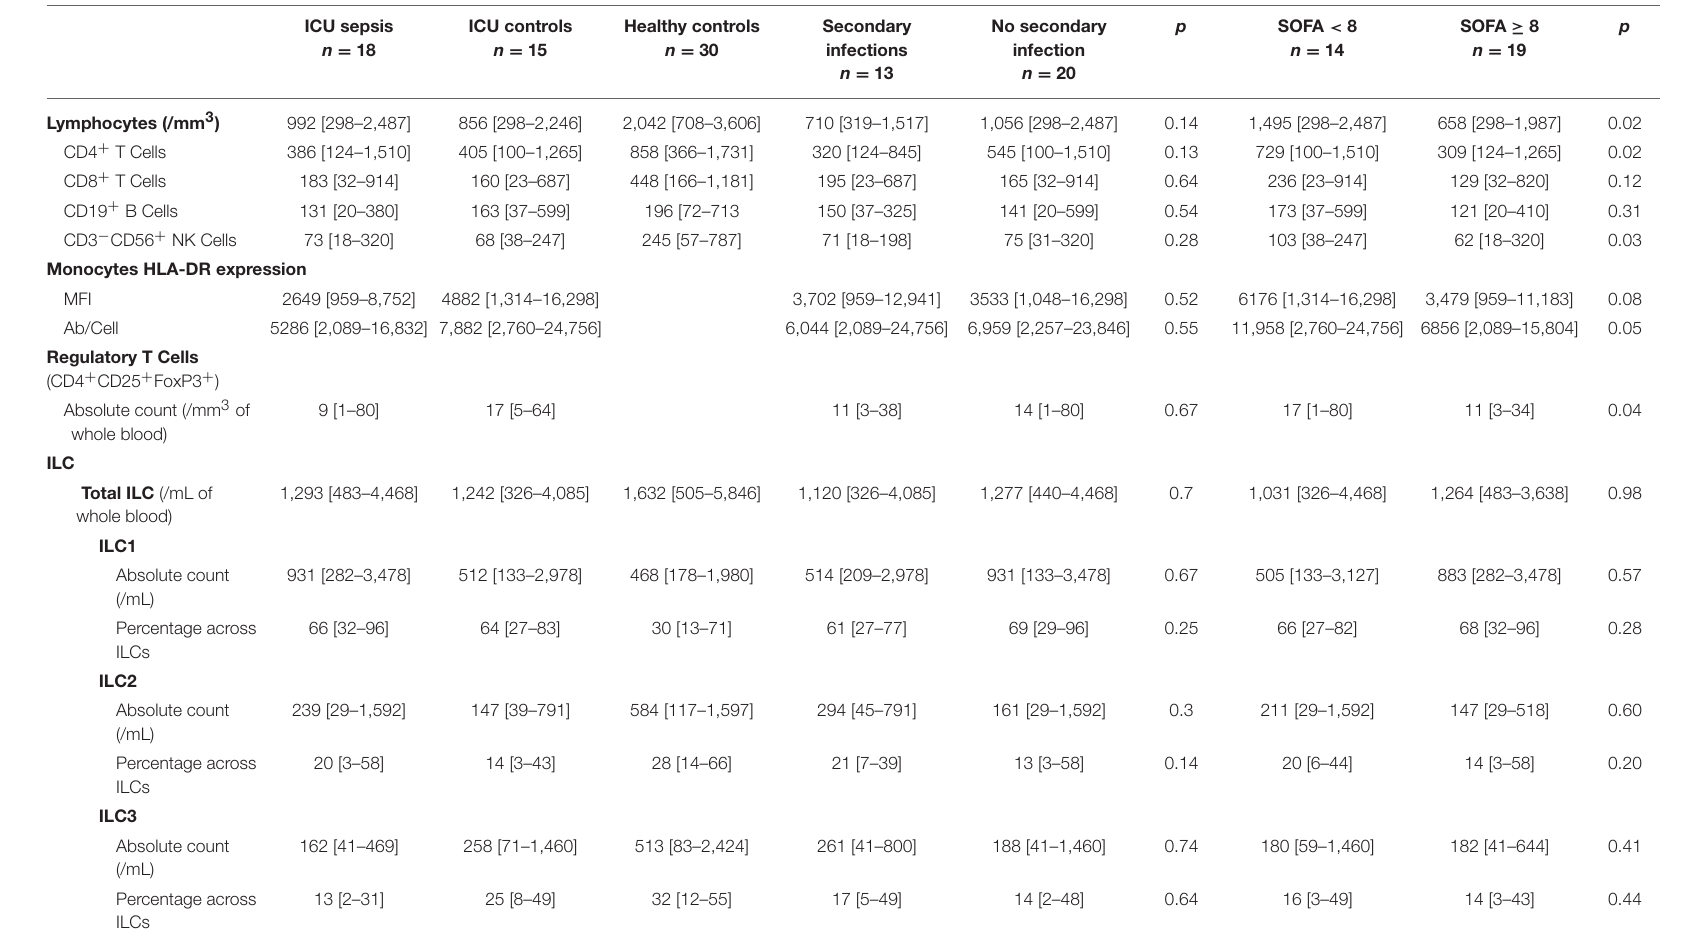
TABLE 4 | Immunological